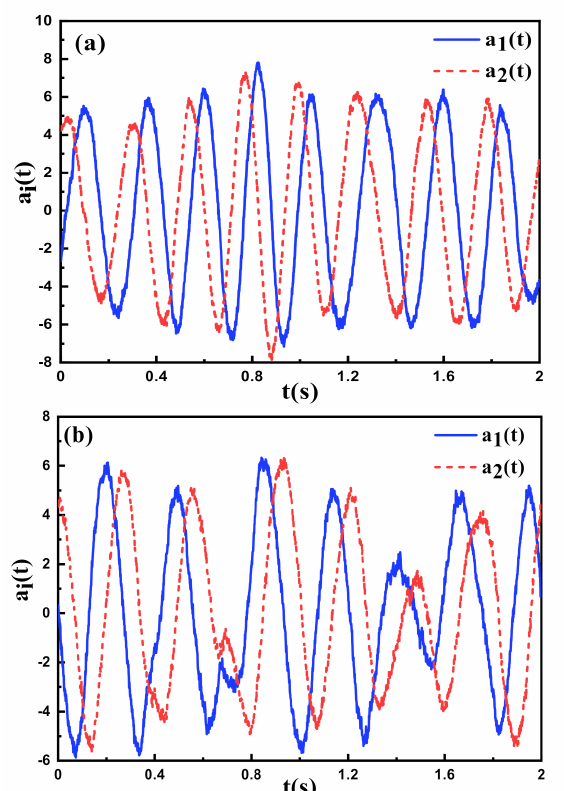
Figure 11. The distribution of POD mode coefficients (Mode 1 and Mode 2) with the temporal variation for case 1 and case 2: ( a ) case 1 and ( b ) case